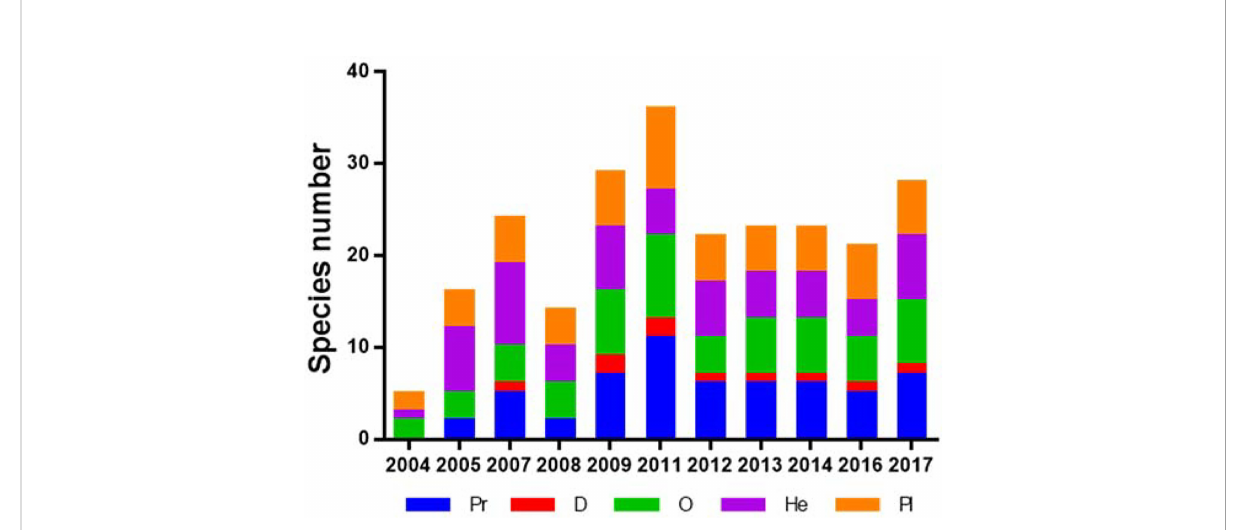
FIGURE 3 Long-term variation in macrobenthos functional group species richness. Pr, predator; D, detritivore; O, omnivore; He, herbivore; and Pl,